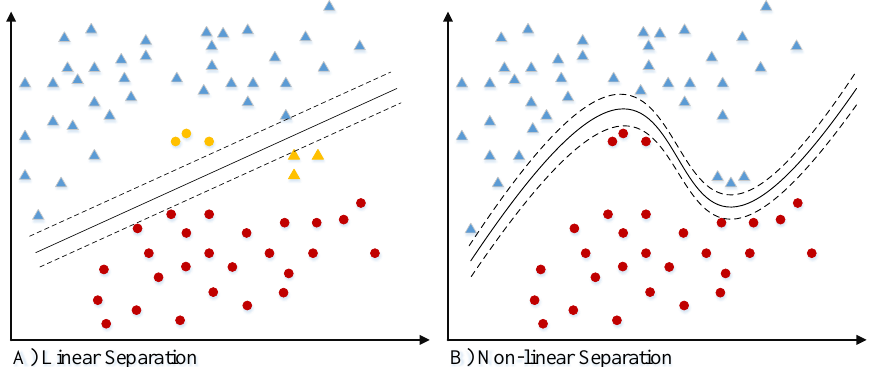
Figure 12. This figure shows the linear and non-linear Support Vector Machine (SVM) for a 2D data set (for text data we have thousands of dimensions). The red is class 1, the blue color is class 2 and yellow color is miss-classified data